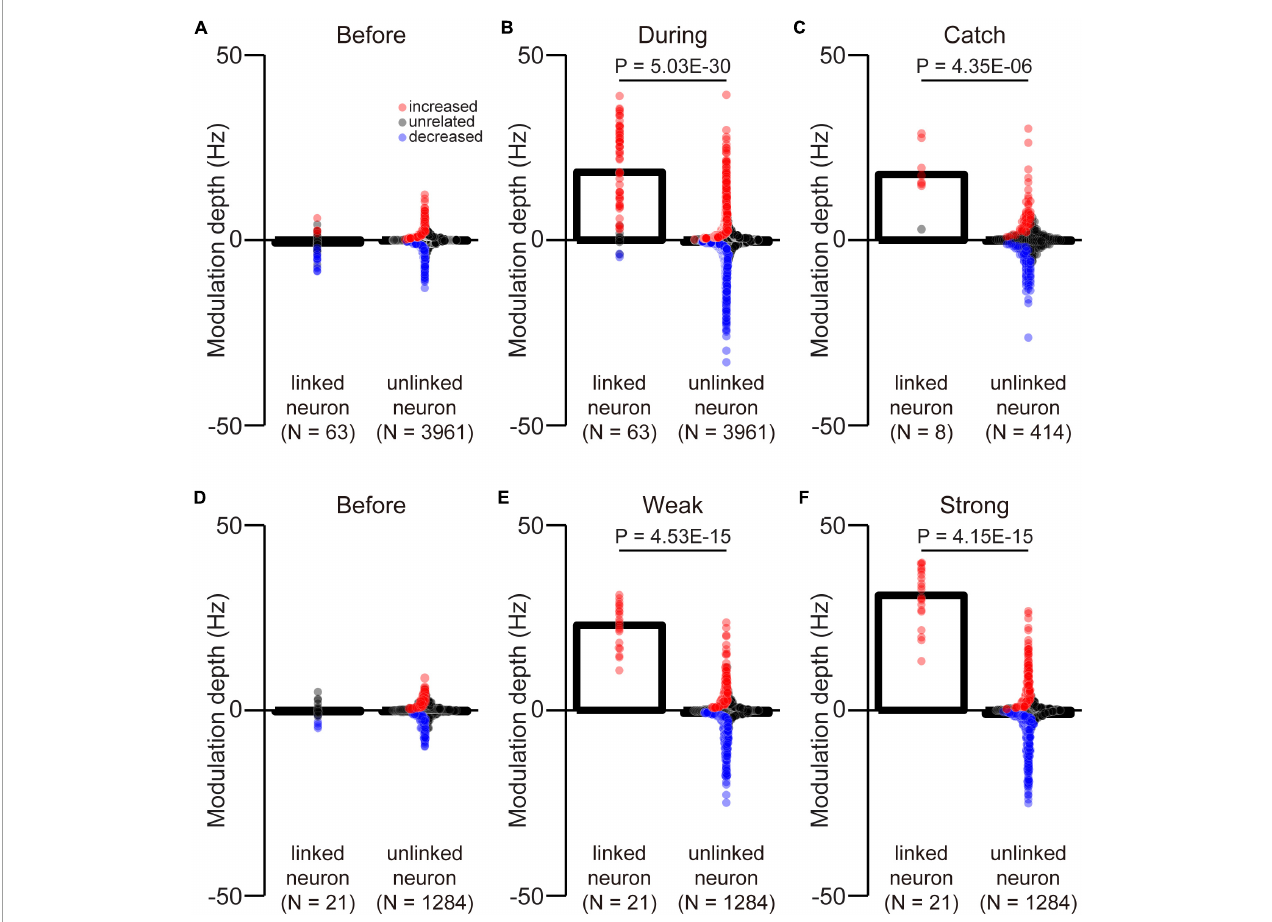
FIGURE9 Difference between the MDs of linked and unlinked neurons. The MDs of linked and unlinked neurons before (A) and during the corticospinal interface trials (B) and during catch trials (C) . The MDs of linked and unlinked neurons before the corticospinal interface trials (D) and during weak (E) and strong trials (F) . Bars and circles indicate the MDs of mean values and individual neurons, respectively. Colors (red: increased neuron, black: unrelated neuron, blue: decreased neuron) of the circles represent the neuron types sorted in each condition (i.e., before and during the corticospinal interface and catch trials). Black horizontal lines represent significant differences ( P < 0.05 by Wilcoxon rank-sum test). Experiments with at least nine trials were included in each